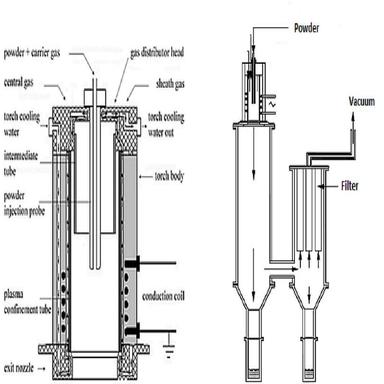
Image showing a) cross-section of PL- 50 Tekna Plasma System Inc. induction plasma torch and b) schematic of the powder synthesis reactor.